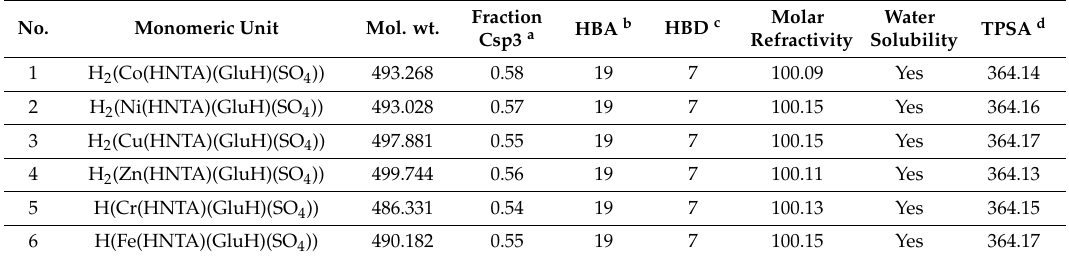
Table 6. Physicochemical properties of the selected compounds (1–6).